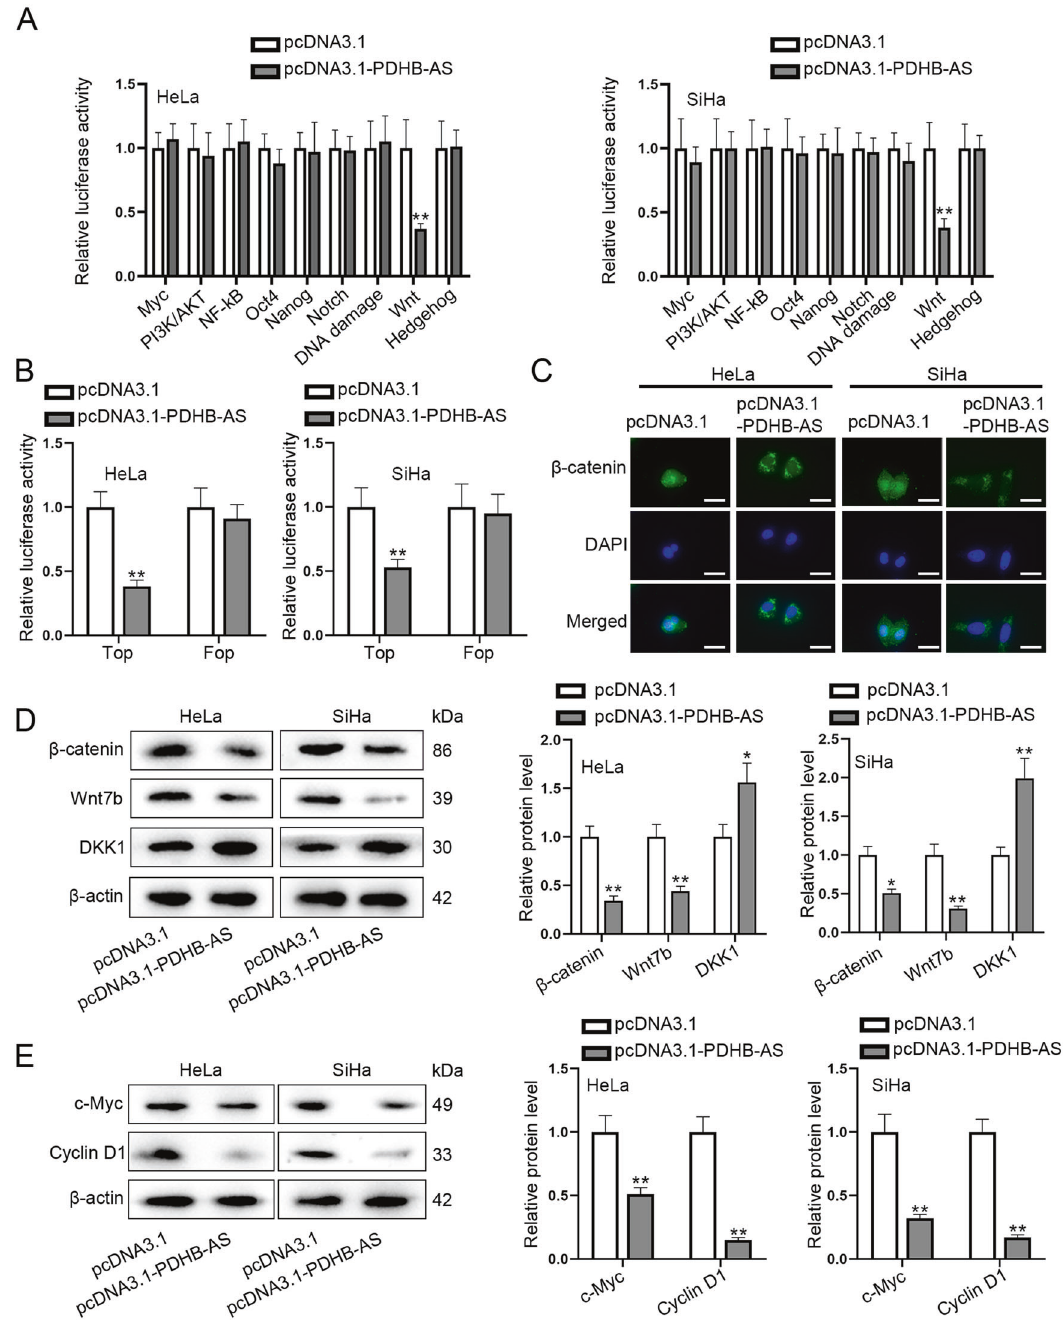
Fig. 3 PDHB-AS inactivates the Wnt/ β -catenin pathway by regulating Wnt7b and DKK1. A Luciferase reporter assay measured the activity of different pathways in HeLa and SiHa cells. B The activity of β -catenin was detected through TOP/FOP fl ash luciferase reporter assay. C IF staining detected the localization of β -catenin in CC cells. D Western blot analysis was performed to measure the protein levels of Wnt7b, DKK1, and β -catenin under PDHB-AS overexpression. E Western blot examined the protein levels of downstream targets of CTNNB1 (c-Myc and Cyclin D1) in CC cells with PDHB-AS overexpression. ** P < Finally, rescue assay was implemented to con fi rm the interaction among PDHB-AS, miR-582-5p, and DKK1. The outcomes revealed PDHB-AS-mediated DKK1 elevation could be restored by over- expressed miR-582-5p (Figure S3E; P < 0.01). In summary, PDHB-AS bound to miR-582-5p to enhance DKK1 expression in CC cells and exerted its inhibitory impacts on CC cell biological behaviors via miR-582-5p/DKK1.